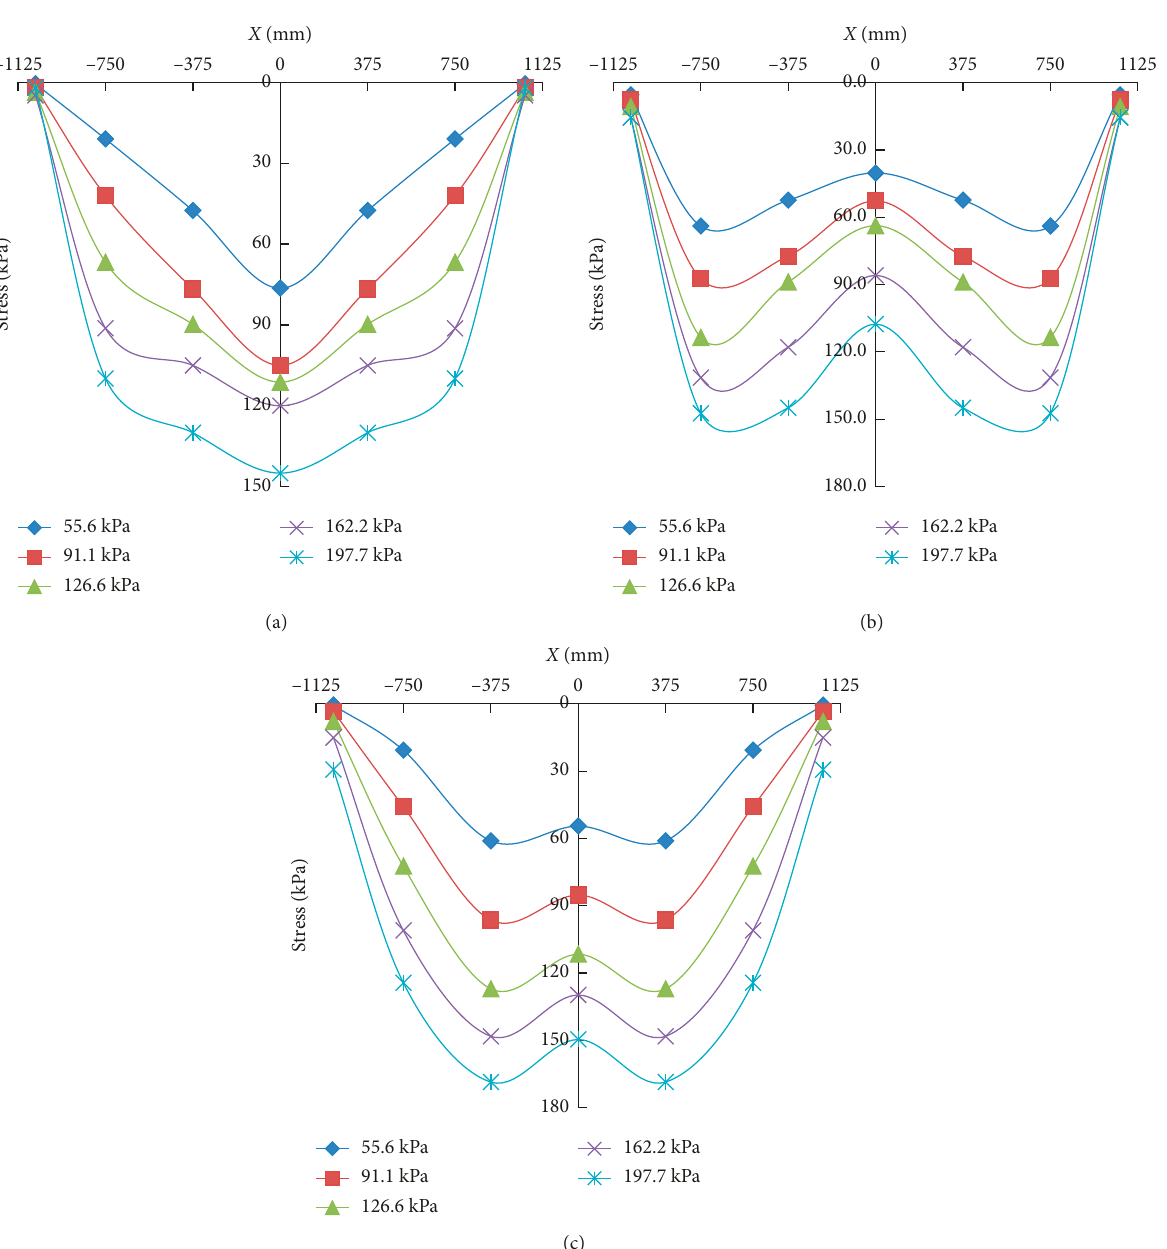
Figure 13: Stress distribution curves under the gravel cushion: (a) A0; (b) A1-1; (c)